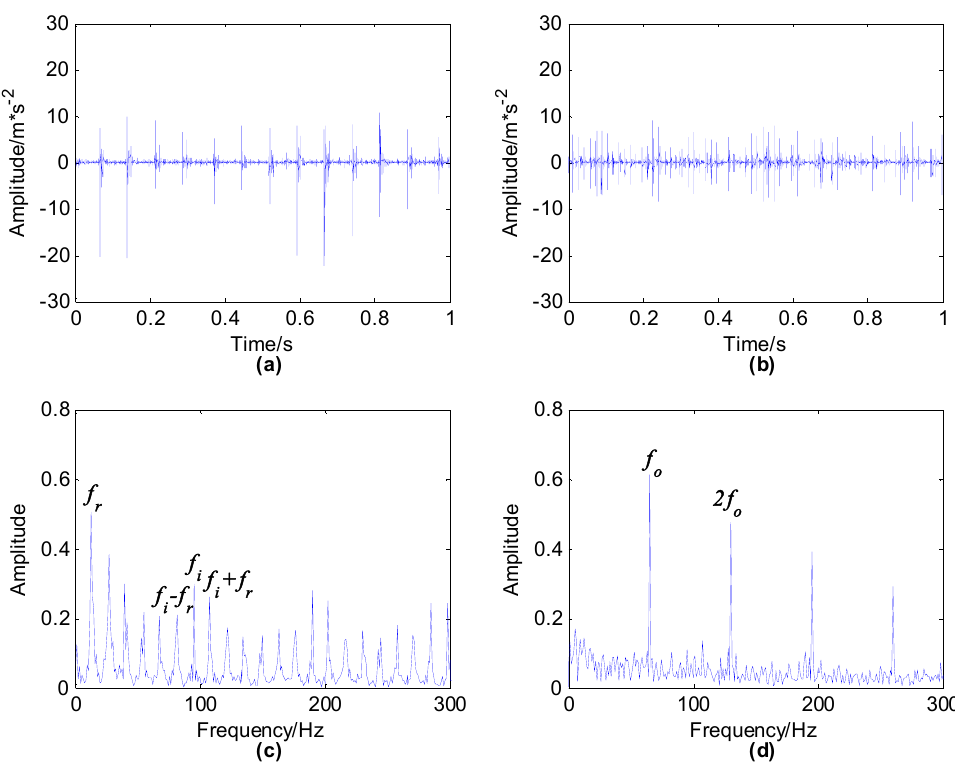
Figure 5. Estimated source signal using improved fast independent component analysis (FastICA): ( a ) source signal x 1 ; ( b ) source signal x 2 ; ( c ) envelope spectrum of x 1 ; ( d ) envelope spectrum of x 2 .